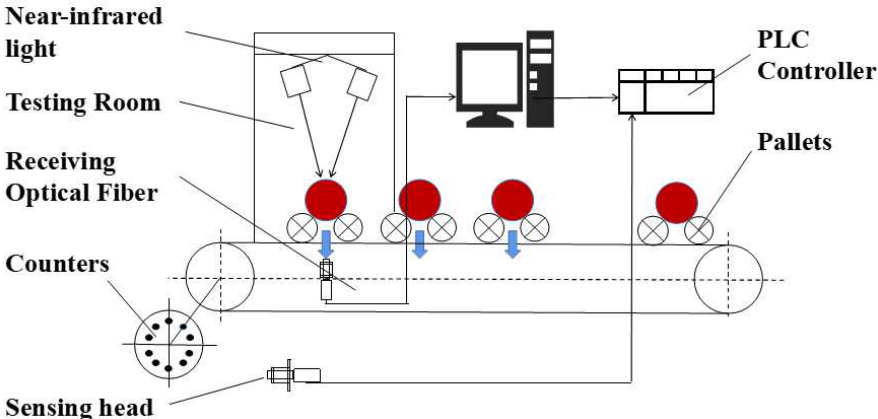
Figure 1. Near-infrared spectra acquisition device.